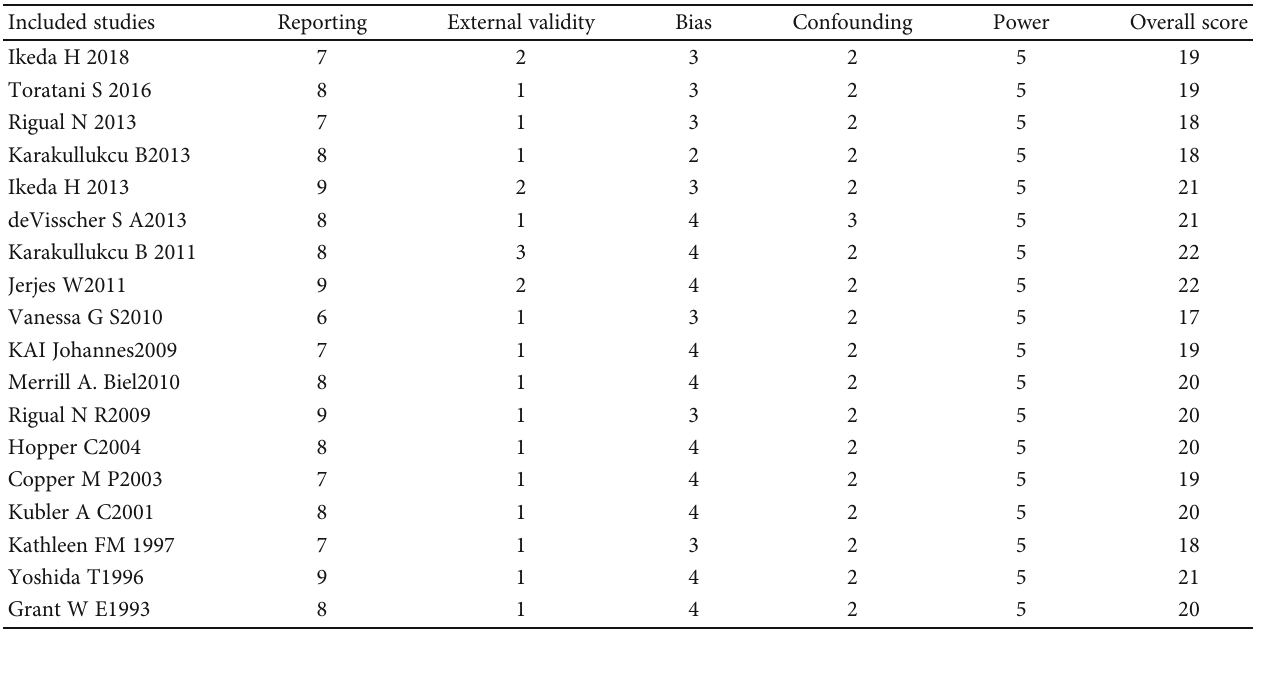
Table 2: Results of bias risk assessment for each included non-RCT (score).